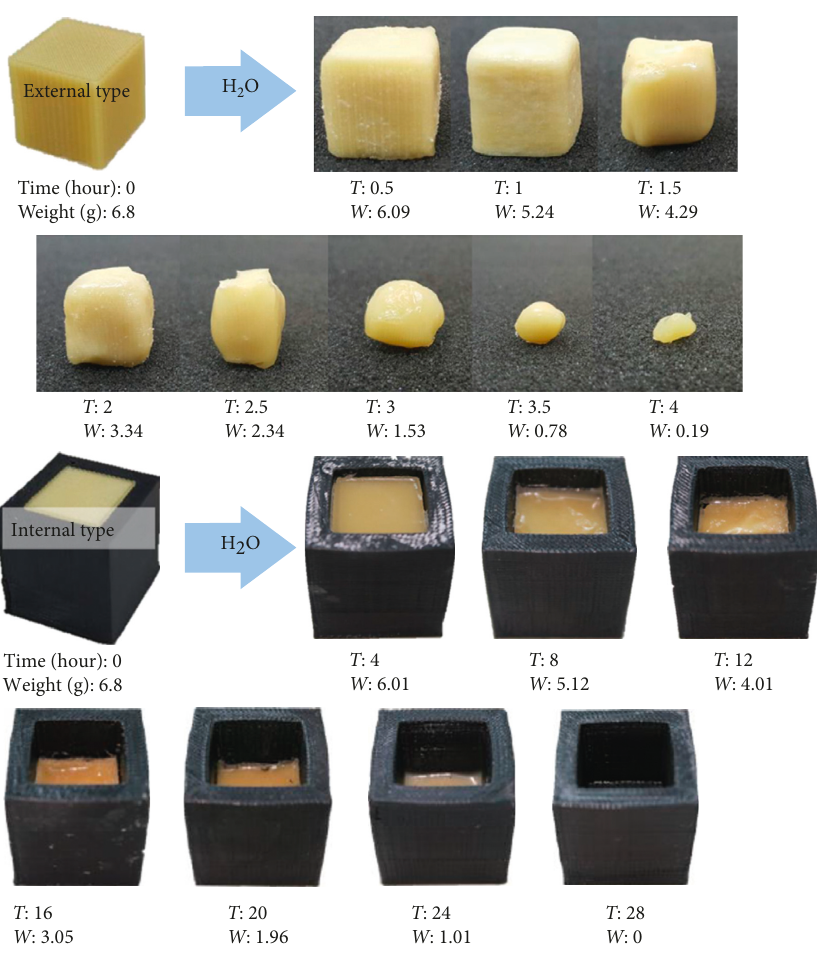
Figure 3: Experimental results of the dissolution of PVA supports in distilled water.